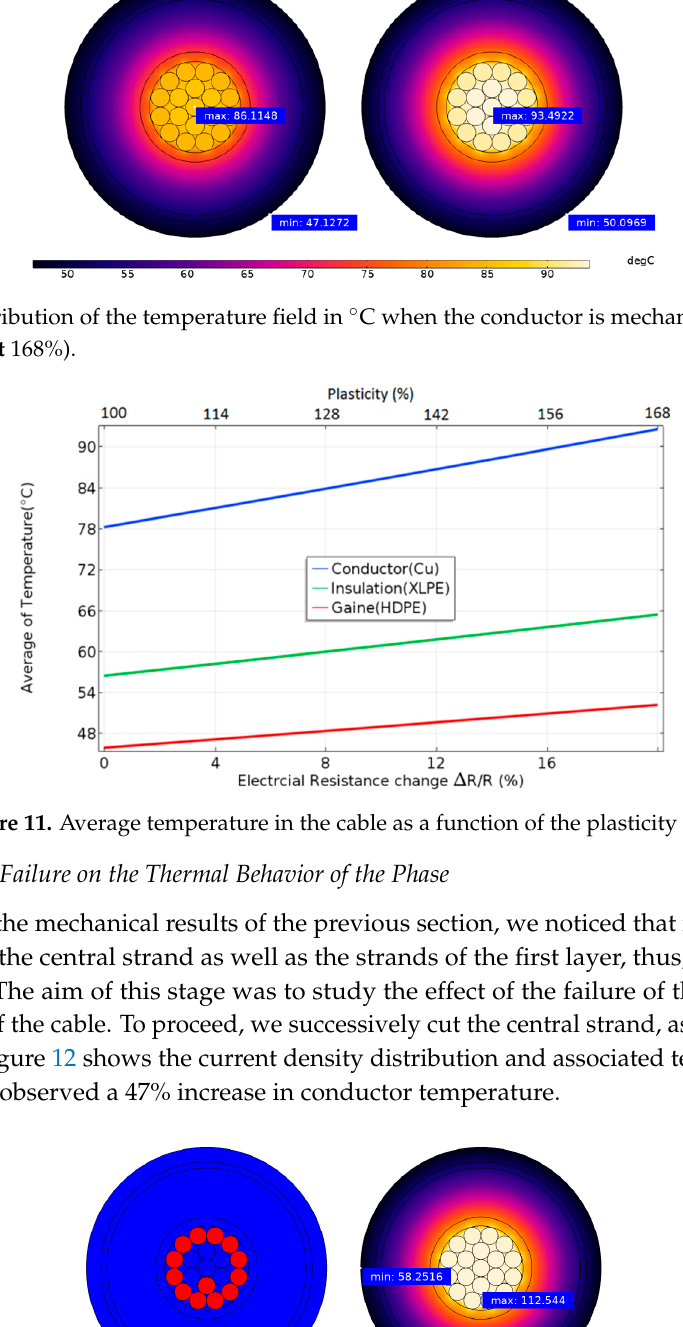
Figure 13. Average temperature in the cable as a function of number of cut wires.